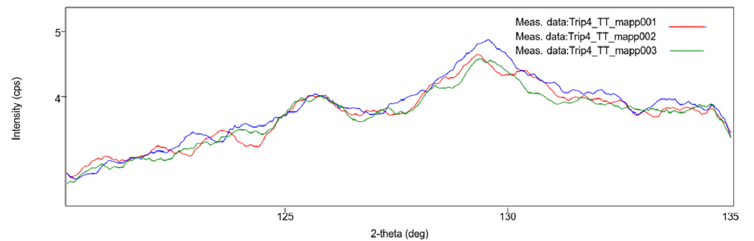
Figure 9. Ferrite peaks (211) measured at three points for the TRIP 4 steel sample after heat treatment.